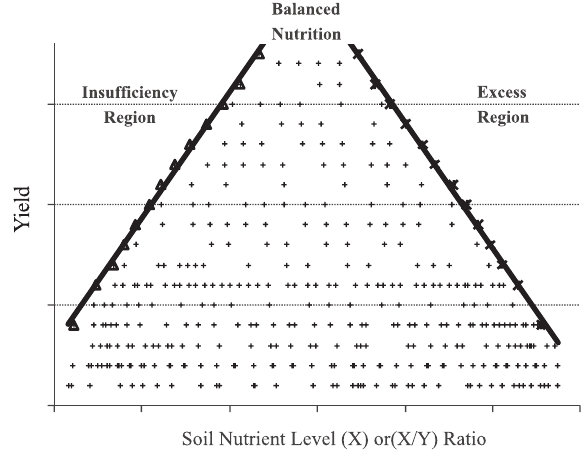
figure 1. diagram to determine the regions of insufficiency, balance and excess of nutrient X, or of insufficiency of y in the ratio X/y (adapted from Summer & farina,